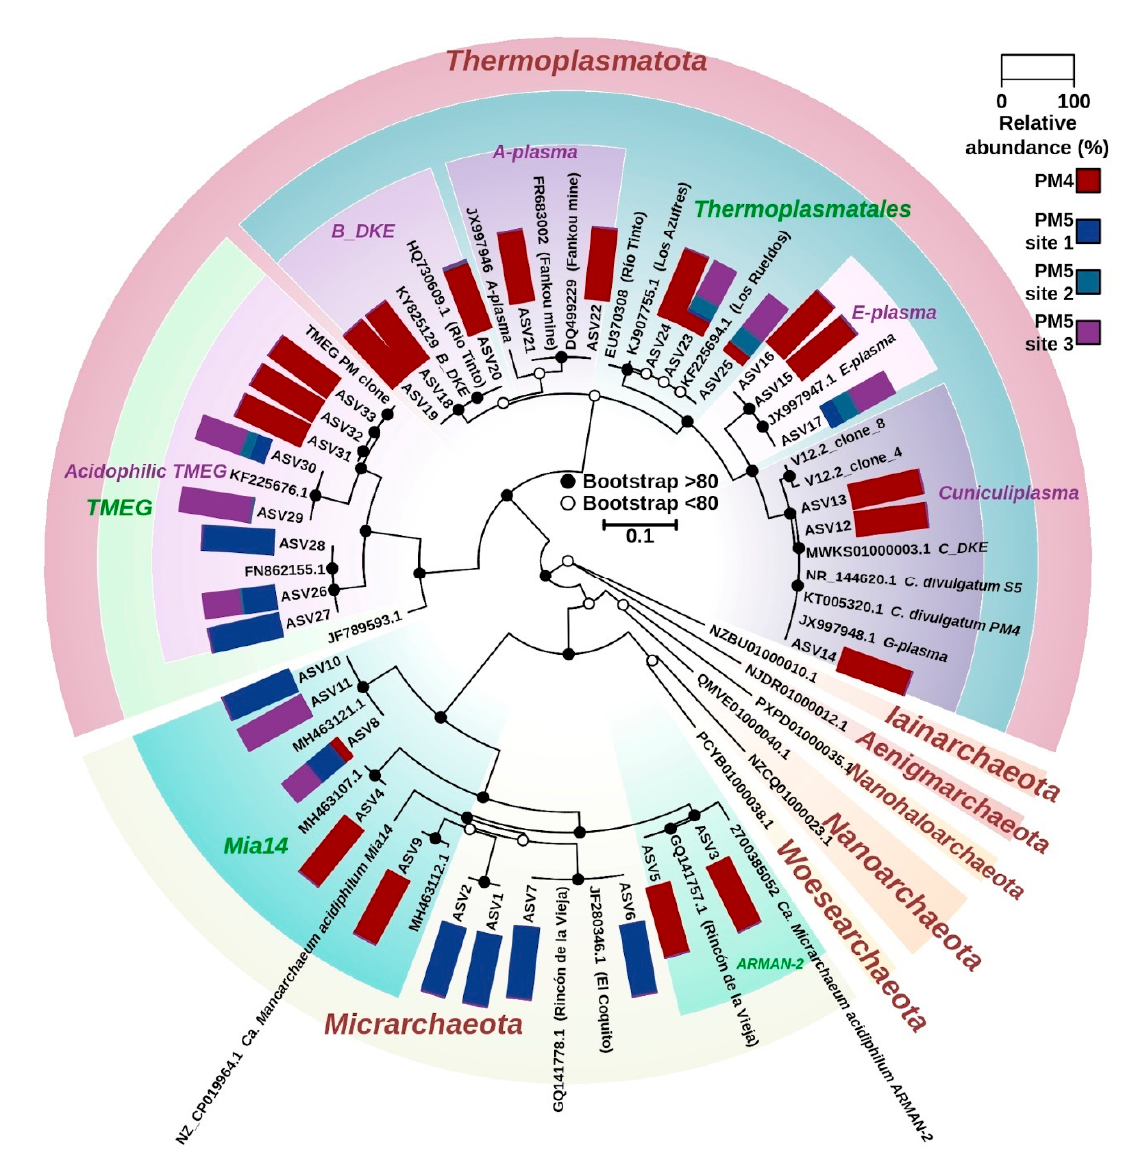
Figure 6. Phylogenetic maximum likelihood tree based on 16S rRNA gene sequences of archaea from sites PM4 and PM5 (PM5.1, PM5.2 and PM5.3), Parys Mt. Relative abundance (%) of reads assigned to each ASV found on PM4 and PM5 sites is shown in the rectangles attached to each ASV label. Bootstrap score is shown by open (<80) or filled (>80) circles for each node. Scale bar, 0.1 substitutions per position.